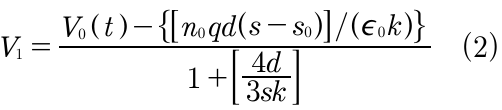
Figure 6. Stoichiometric formulae of the (a) aluminum acetylacetonate (AlC (b) aluminum oxide (Al